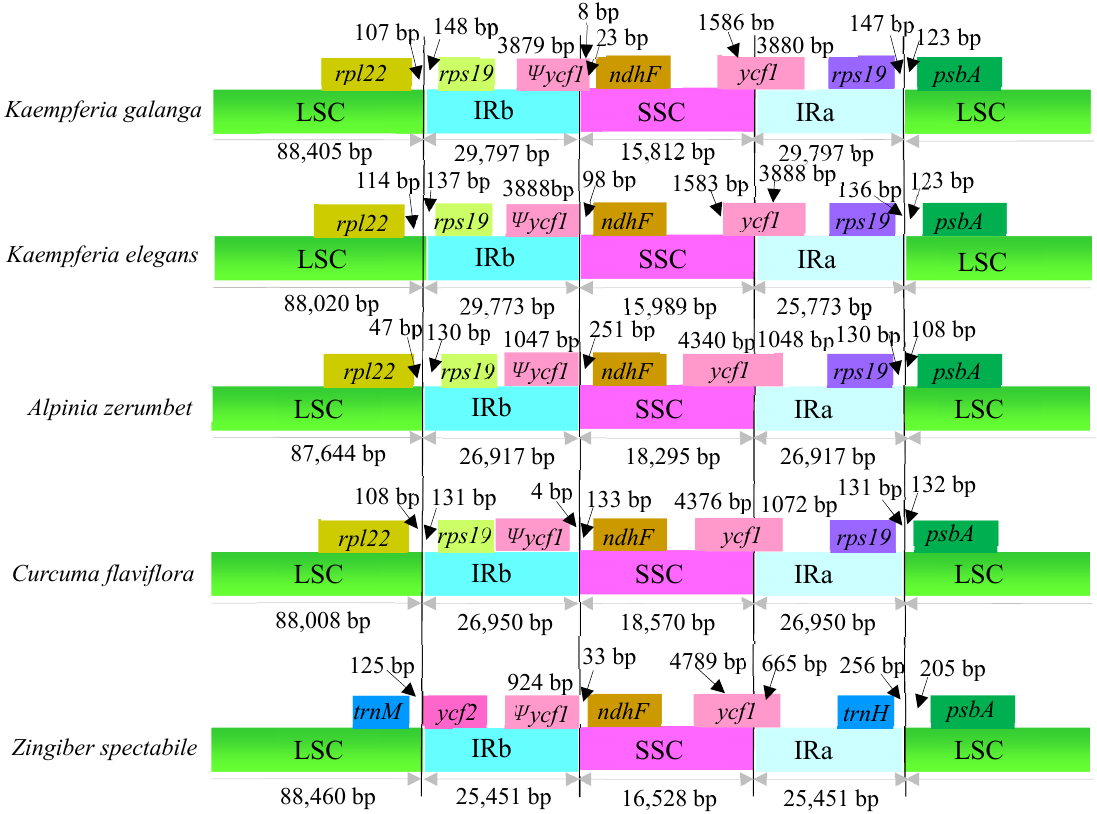
Figure 5. Comparison of the borders of the LSC, SSC and IR regions among five Zingiberaceae chloroplast genomes. Ψ , pseudogenes. Boxes above the main line indicate the adjacent border genes. The figure is not to scale with respect to sequence length and only shows relative changes at or near the IR/SC borders.